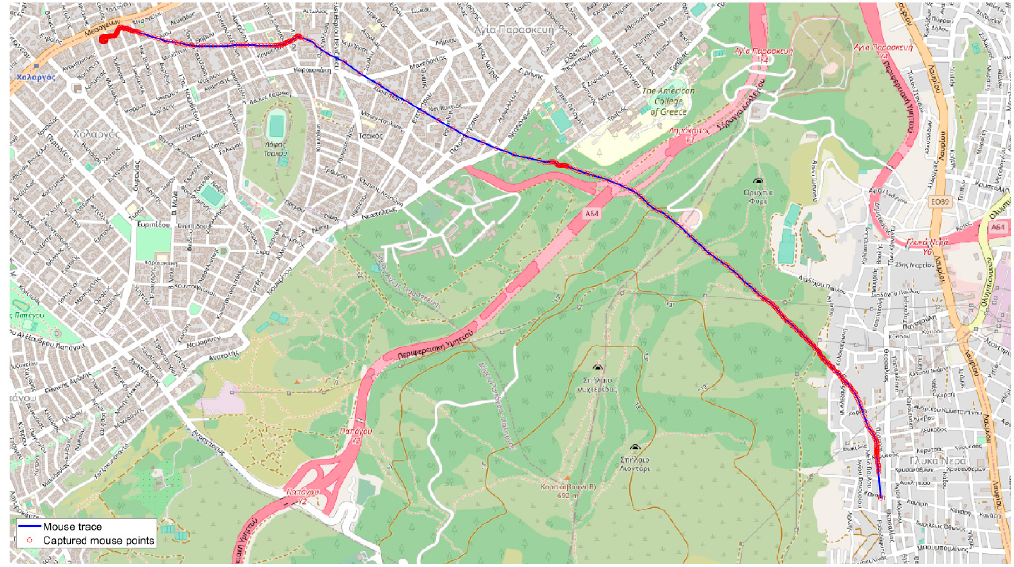
Figure 3. Visualization of the generated mouse trajectory during visual search on experimental stimulus: Mouse trace is presented as a continuous blue line while captured mouse points are highlighted with red circles.